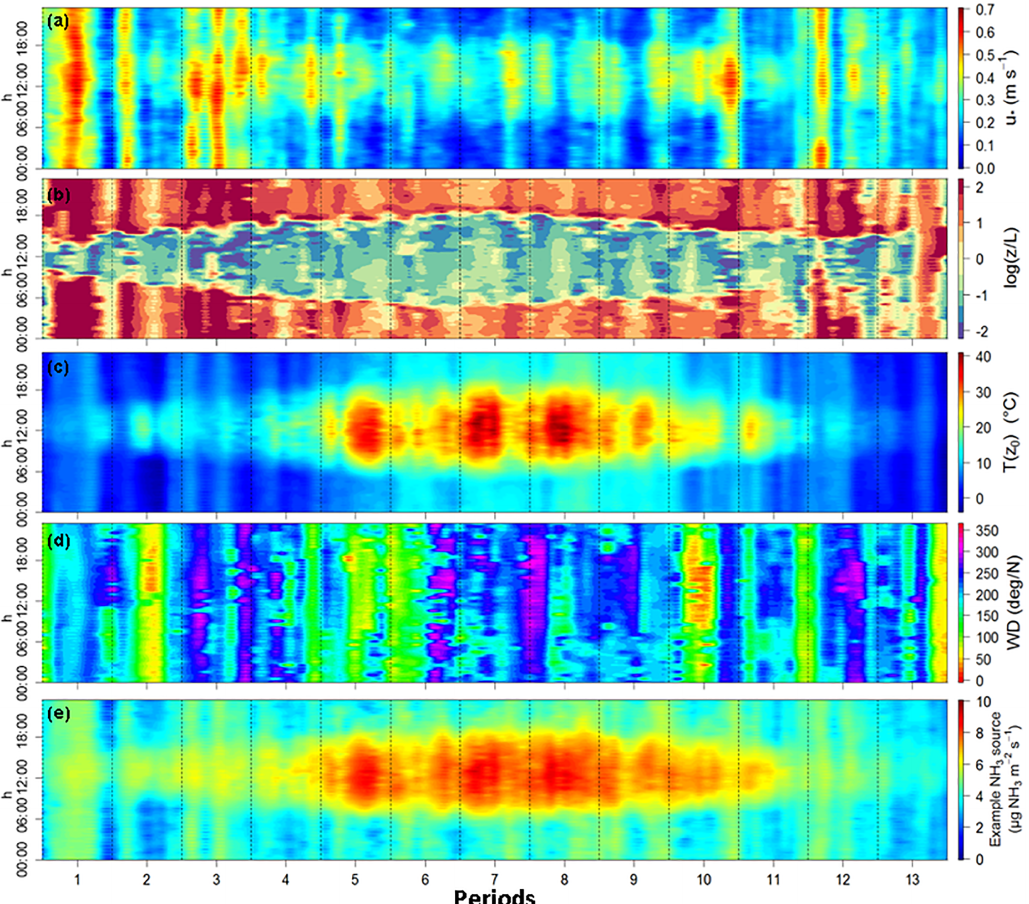
Figure 3. Footprints of measured u ∗ (a) , z/L at 1m height (b) , T (z 0 ) (c) and wind direction (d) for the hour of the day and the 13 considered periods over the year 2008 at the FR-Gri ICOS site. The modelled ammonia source is also reported (e) according to Eqs. (9) and (10) over the same period with an emissions potential (cid:48) =